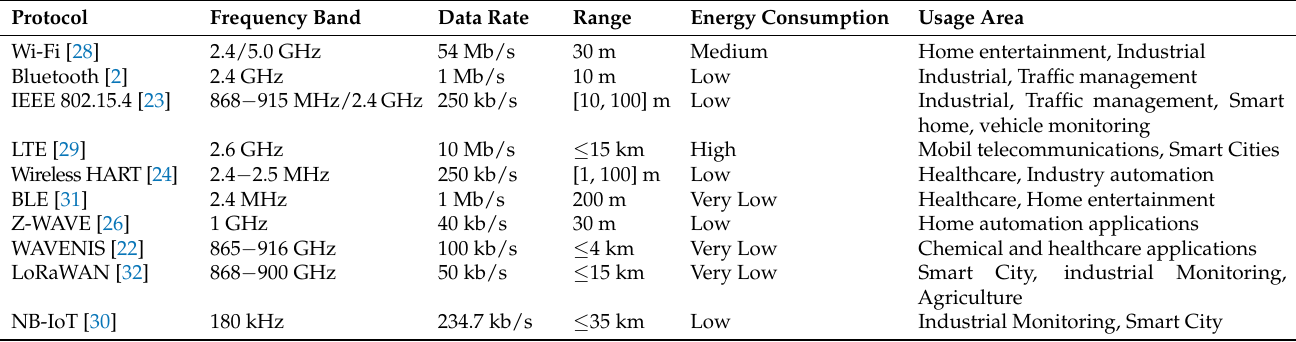
Table 1. Comparison of characteristics of different communicatioTn